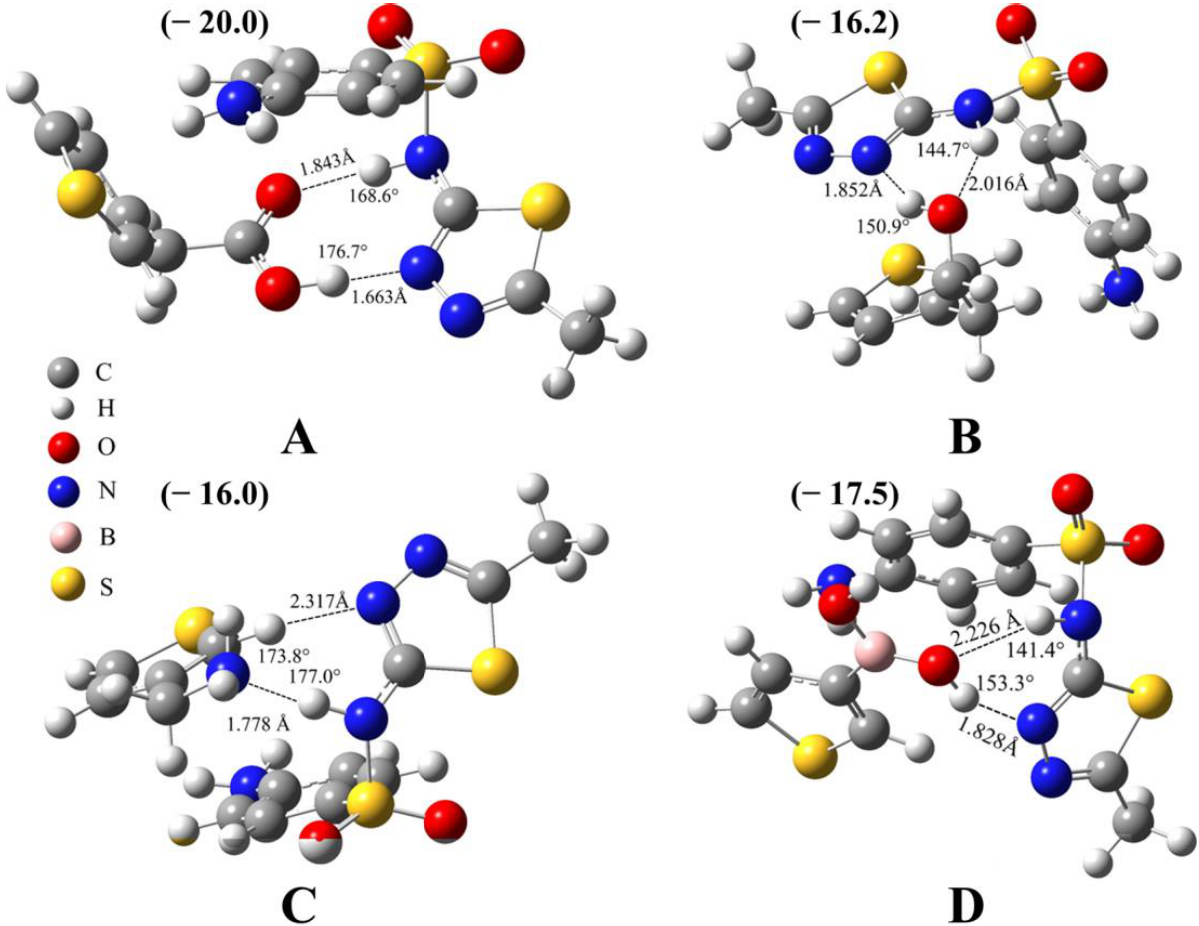
Figure 1. Optimized 3D complex structures between sulfamethizole and ( A ) 3-thiopheneacetic acid, ( B ) 3-thiopheneethanol, ( C ) 3-thiophenemethylamine, and ( D ) 3-thiopheneboronic acid. The presence of hydrogen bonds is indicated by the light black dashed lines. The values near the hydrogen bonds are the bond lengths and bond angles, and values in brackets are binding energies; unit: kcal/mol. Level of theory: PWPB95(D3-BJ)/def2-QZVPP//B97-3c.